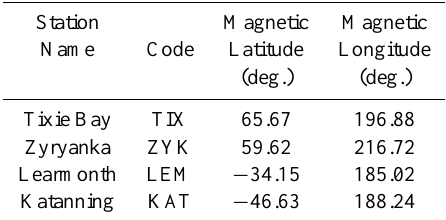
Fig. 6. Linear fit to ln (C/C ◦ ) versus time for the three images taken at 14:00:09, 14:02:12 and 14:04:15UT. C is the peak count rate in the onset region of the growth phase arc ( C ◦ is the value of C in the 14:00:09UT image). The intensity is consistent with a linear growth rate of γ = 0 . 0053s − 1 . Table 1. Selected 210MM magnetometer